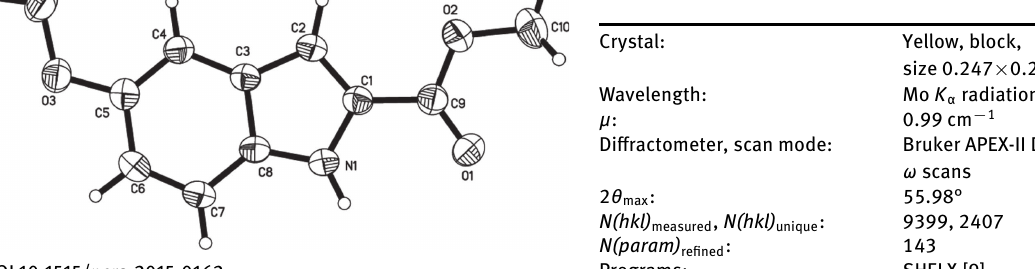
Table 1: Data collection and handling.